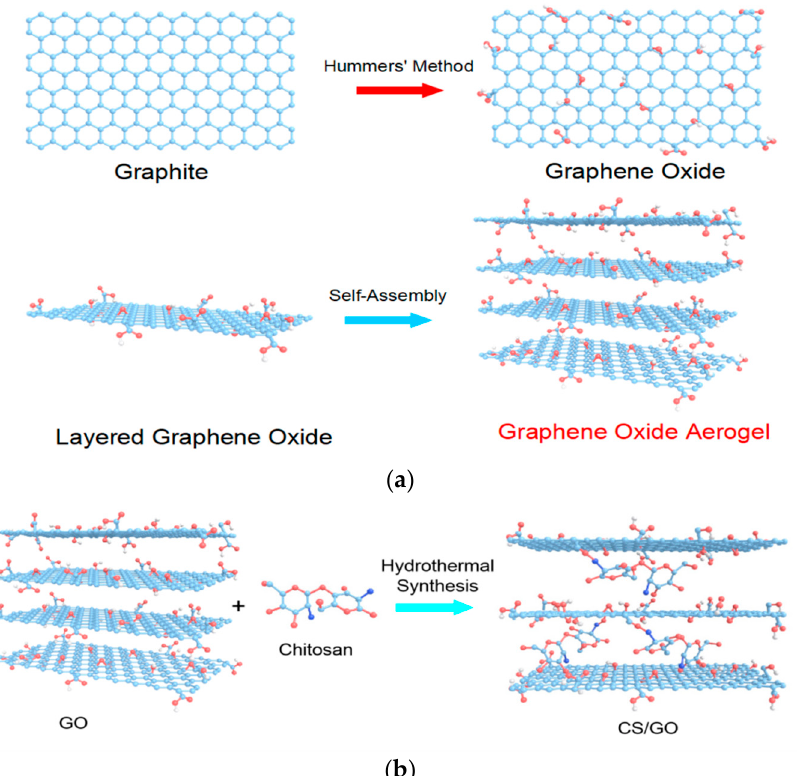
Figure 1. Schematic illustration of the synthesis mechanism: ( a ) GO aerogel, ( b ) CS/GO aerogel.